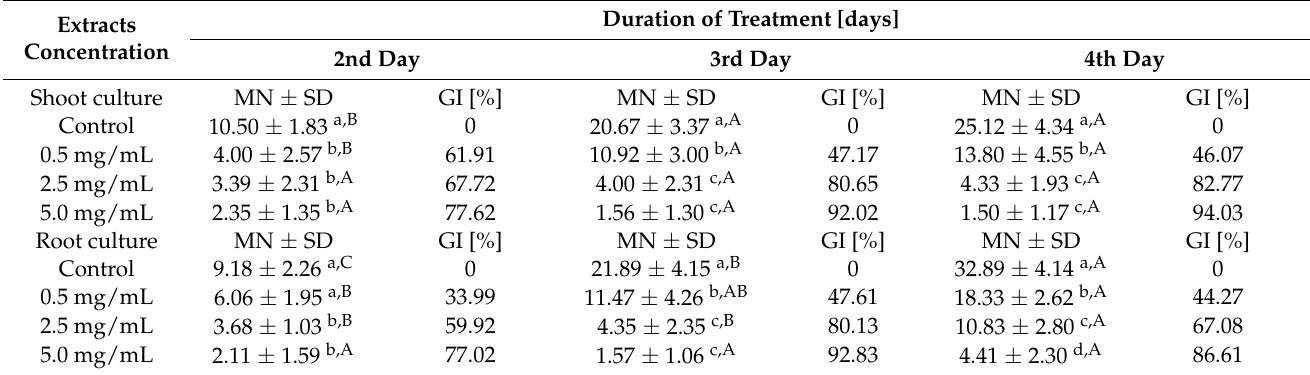
Table 7. Effect of extract from Eryngium planum shoot and root in vitro culture on inhibition of Acanthamoeba trophozoites during four days